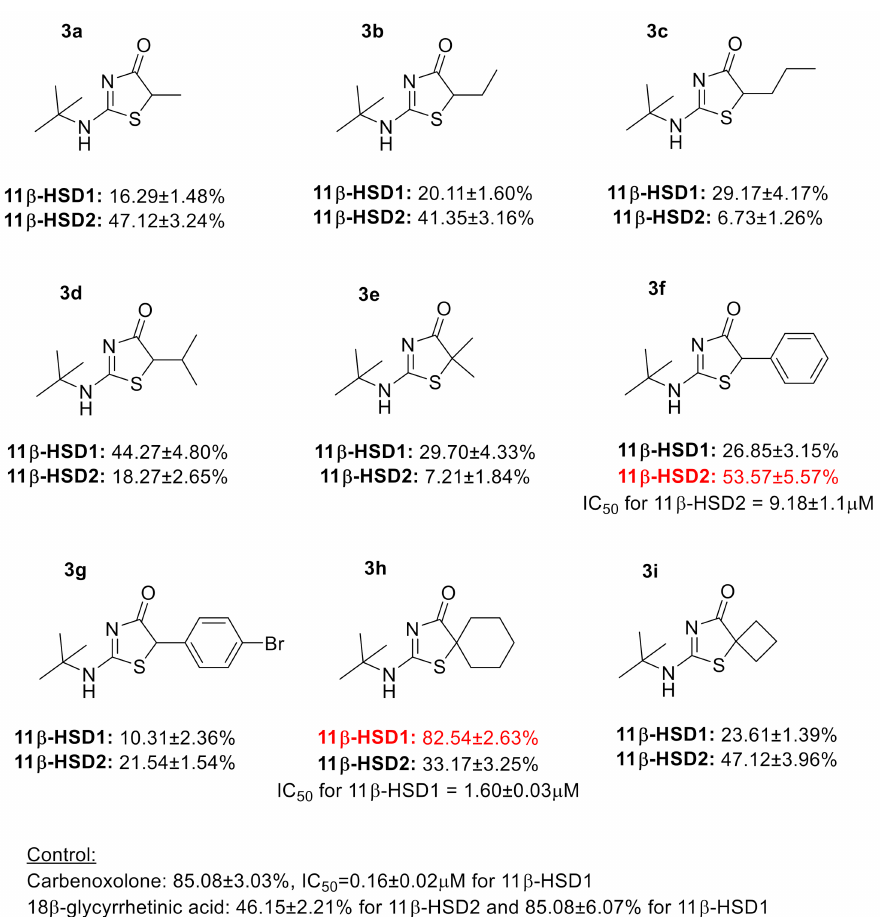
Scheme 5. Inhibitory activity of 2-( tert -butylamino)thiazol-4(5 H )-one